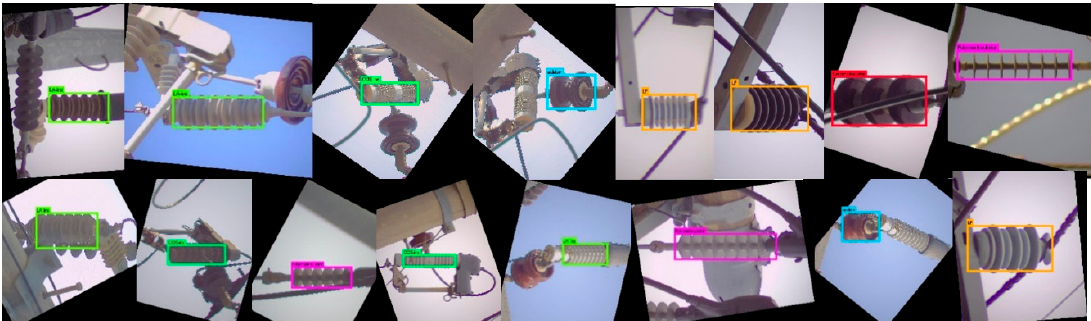
Figure 5. Detection results of the CNN-based multi-type HR_2 detector. The orientation of the insulator image is normalized before feeding it to the HR_2 detector. The tight and precise detection of the insulators helps in better cap segmentation by our novel ellipse detector, which is a robust alternative to the color-based segmentation [26].